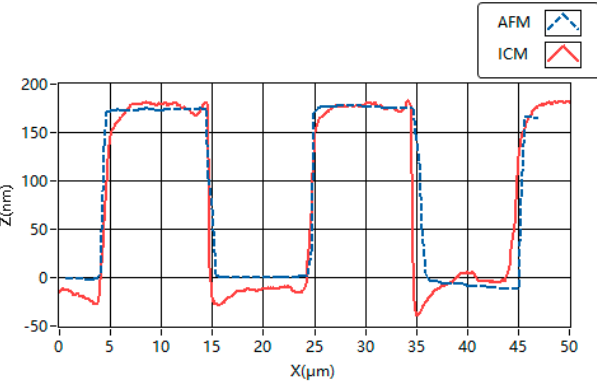
Figure 7. Profiles of the grooves obtained with AFM and the proposed ICM.